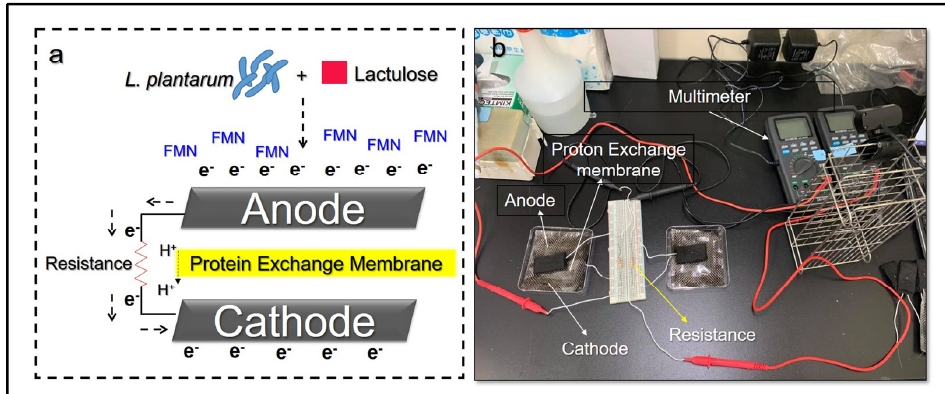
Figure 1. Identification of the bacteria isolated from the Mongolian fermented Airag. ( a ) Schematic diagram of the MFCC operations. ( b ) Photograph of the real MFCC device.